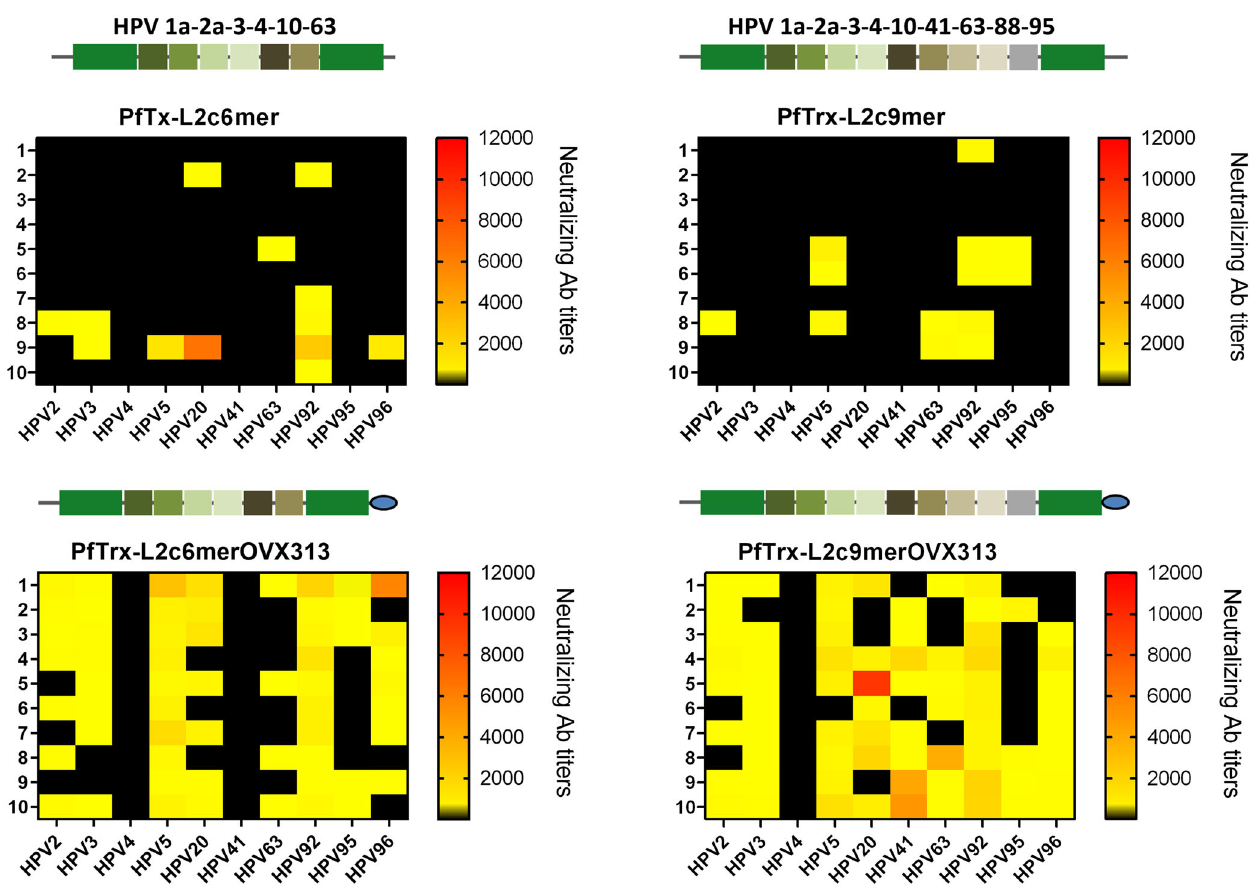
Fig. 1 OVX313-mediated heptamerization boosts the immunogenicity of both the PfTrx-L2c6mer and the PfTrx-L2c9mer antigens in mice. Heat maps show the neutralizing antibody titers against 10 cutaneous HPV types, measured by the L1-PBNA in sera from 10 mice (each row represents one serum) immunized with 20 µg of the four cHPV PfTrx-L2 antigens. Antibody titers ranging from 50 to 12,000 are color- coded in yellow to red; black color indicates EC50 values <50 (no neutralization). At the top of each heat map, the antigen schematics illustrate the HPV L2 epitopes (squares) genetically inserted into the PfTrx protein (rectangle), and the presence or absence of the OVX313 domain (blue circle)